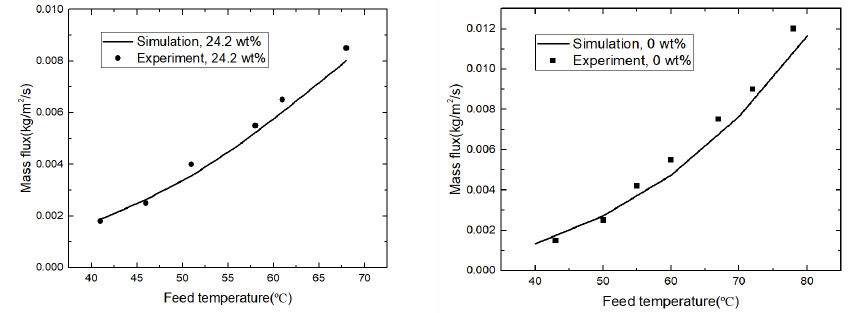
= 24.2 wt.%, left ; pure water, right f ( c f